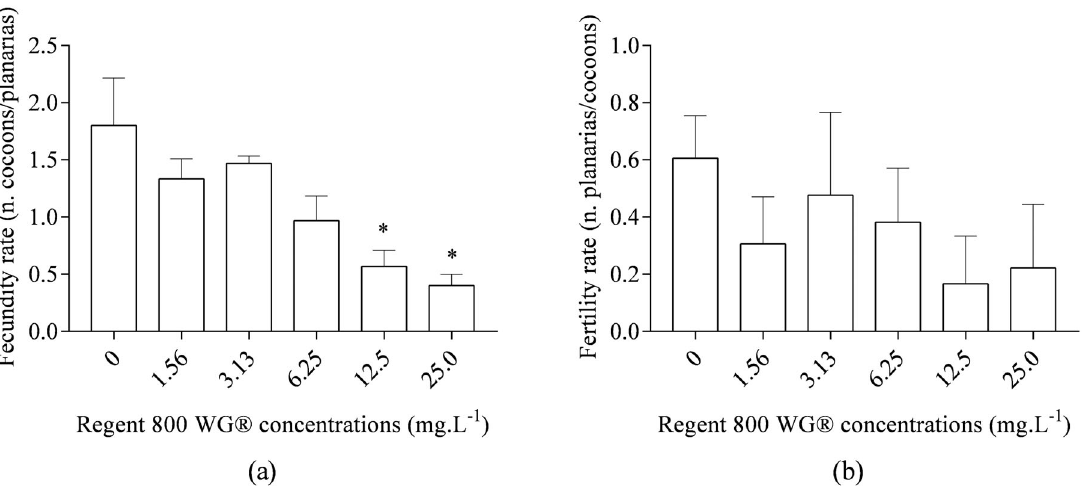
Figure 3. Effects of sublethal concentrations of Regent 800 WG ® on the reproduction of the G. tigrina . ( a ) Fecundity rate. ( b ) Fertility rate. Concentrations refer to active ingredient of fipronil. Data are presented as mean ± standard error, n = 30. * Significant differences are observed in comparison with the control treatment (Dunn’s post hoc test).